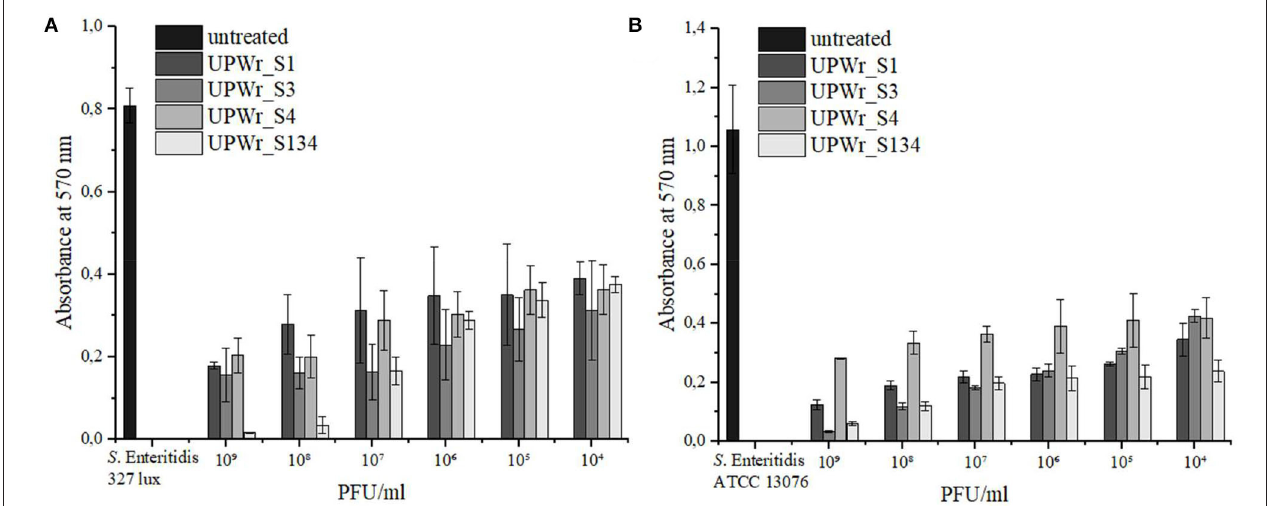
FIGURE 2 | Effect of UPWr_S1, UPWr_S3, and UPWr_S4 phages and phage cocktail UPWr_S134 on biofilm on stainless steel washers. (A) Effect of UPWr_S1, UPWr_S3, and UPWr_S4 phages and phage cocktail UPWr_S134 on reduction of biofilm formed by S . Enteritidis 327 lux, and (B) effect of UPWr_S1, UPWr_S3, and UPWr_S4 phages and phage cocktail UPWr_S134 on reduction of biofilm formed by S . Enteritidis ATCC 13076. Values represent the mean with a standard deviation of three